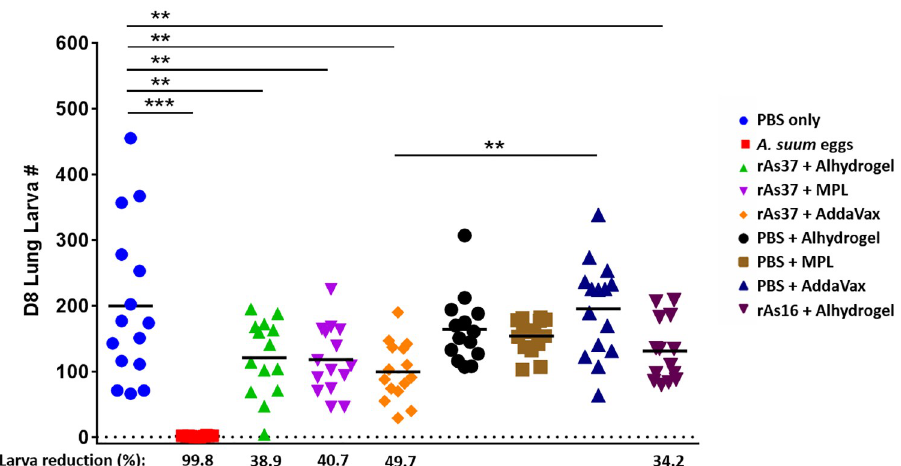
Fig 6. Lung larva reduction in mice immunized with rAs37 formulated with different adjuvants (Alhydrogel, MPLA, AddaVax) on Day 8 after being challenged with 2,500 A . suum eggs, presented as the mean ± SD (N = 15). L The asterisks indicate statistically significant differences in larval reduction compared to the PBS or adjuvant control groups ( �� p < 0.01, ��� p < 0.001).